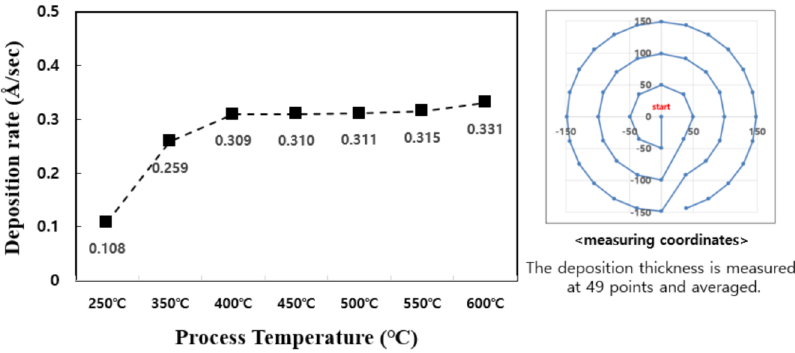
Figure 1. Comparison of deposition rates of TiN thin films per cycle over process temperature.